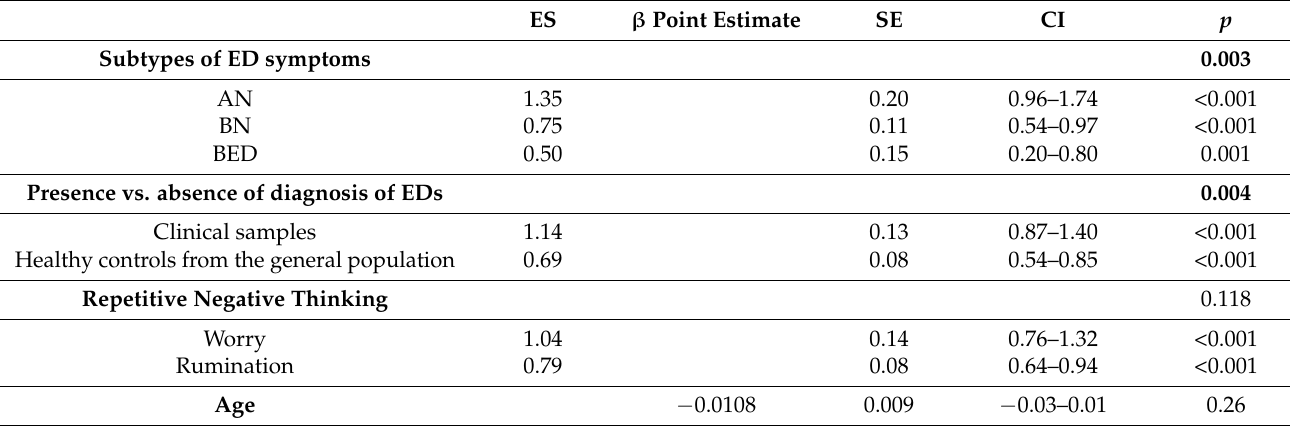
Table 3. Moderator analyses: subtypes of ED symptoms, presence vs. absence of diagnosis of EDs, worry–rumination and